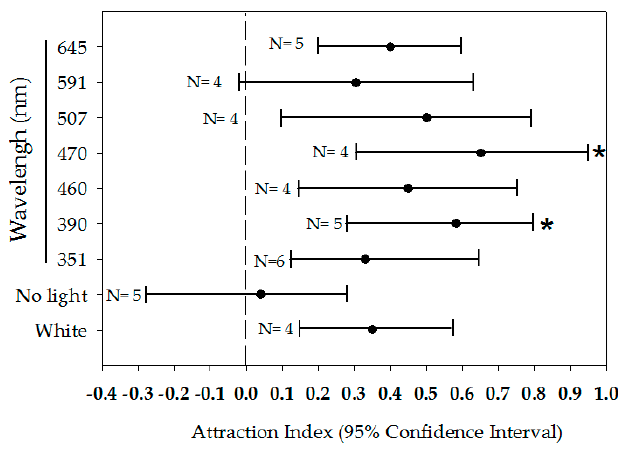
Figure 4. 95% confidence intervals of attraction index means of Triatoma rubida males to different light wavelengths. Bootstrap analysis reveals that wavelengths of 470 and 390 nm are significantly more attractive than the control (no light) ( p > 0.05).